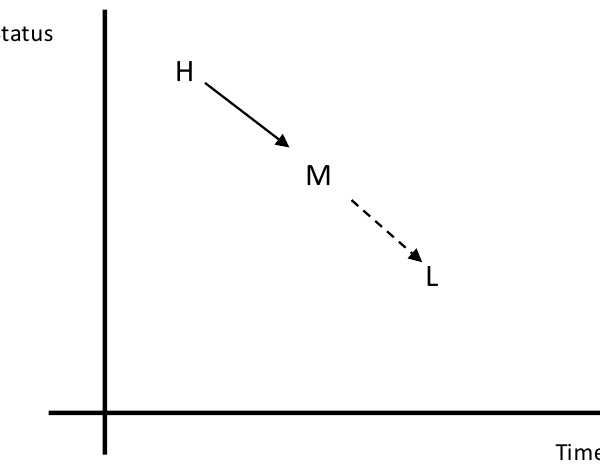
Fig. 2a. Diffusion in an Incomplete Status Hierarchy 360